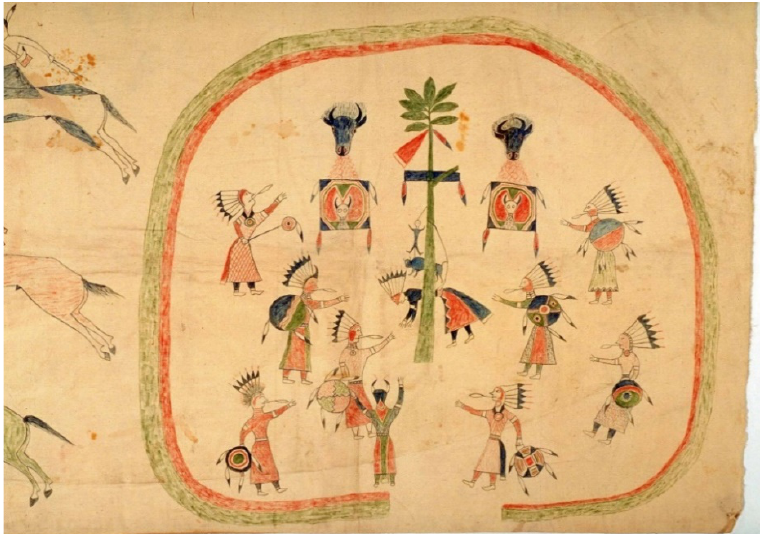
Figure 5. Painting on Muslin. Attributed to Siyosapa (Hunkpapa/Yanktonai) Collected at Fort Peck, Montana in 1880/1881. Cotton muslin, paint, 259 cm × 178 cm. Used by permission of National Museum of Natural History (EL81-0).